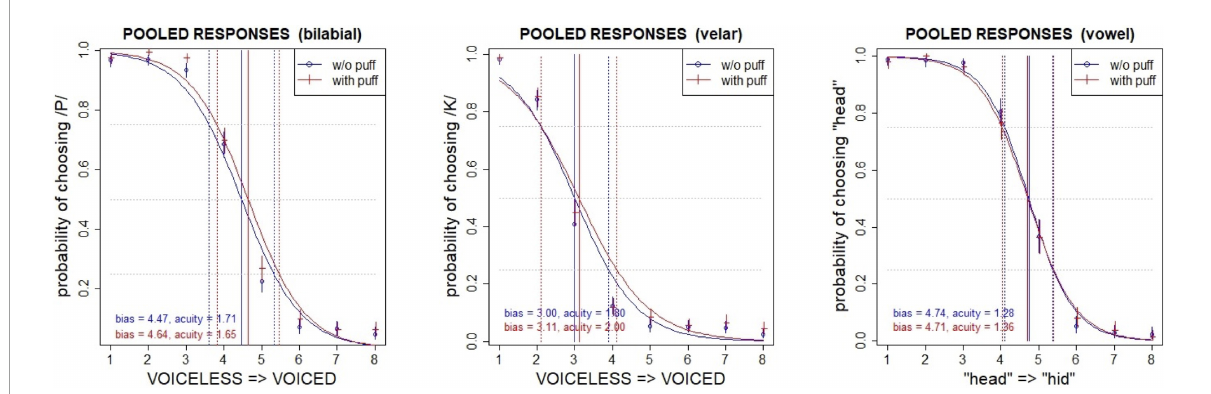
FIGURE4 Perceived category boundaries, pooled across speakers, with (red) and without (blue) an air puff. Vertical lines show the bias (50%) crossover, which is systematically shifted in the direction of voiced responses for +puff trials in the bilabial (left) and velar (center) continua, but not in the control vowel continuum (right). 95% confidence intervals are indicated for each pooled response.